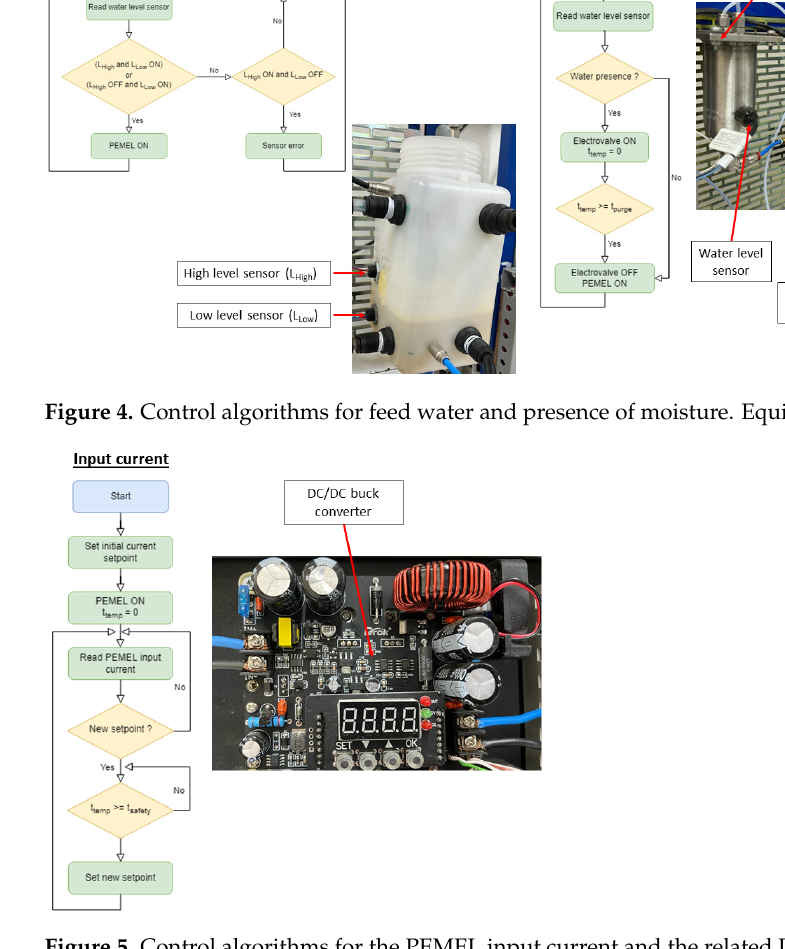
Figure 6. Input current and H 2 flow curve. 4. Conclusions This article has presented a hydrogen generation system managed by means of con- trol algorithms based on sensor signals. The PEMEL has been described as the central core of the system, with emphasis on its operating principle and structure. The set of sensors and actuators used and their relationship with the selected control parameters have been detailed. The selection of these parameters has been made considering performance and safety aspects of the system. Finally, the different control algorithms implemented in the PLC for the management of the system have been described, indicating the components involved in each of them. Further research guidelines include studying long-term opera- tion of the PEMEL under the control of the reported algorithms.